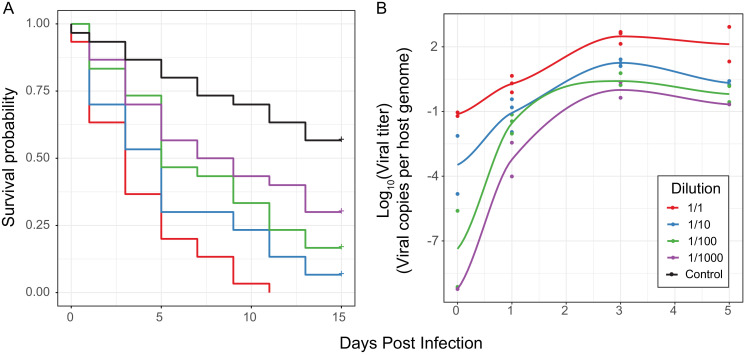
Effect of differences in viral type and titer in experimental infections.(A) Survival curves of D. innubila infected with DiNV filtrate of different dilutions compared to control flies pricked with sterile media, for 15 days post infection. Each dilution was used to infect 30 flies in 3 replicates of 10. (B) qPCR copy number of viral p47 relative to tpi in samples of D. innubila infected with DiNV filtrate of different dilutions, between 1 and 1000 viral particles per host genome copy. 2 to 3 replicates of 5 flies were quantified at each timepoint, with later time points limited to two time points due to lack of surviving flies.